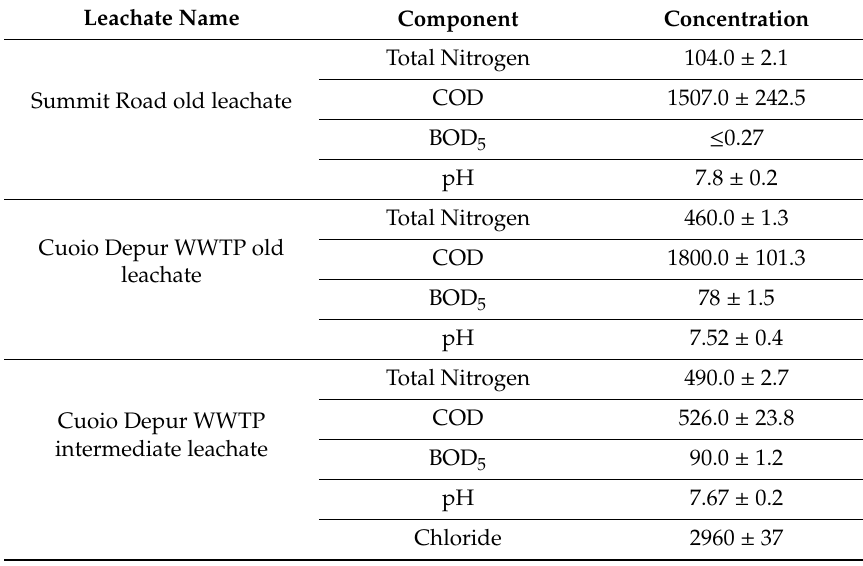
Table 1. Characteristics of the old, and intermediate Landfill Leachates